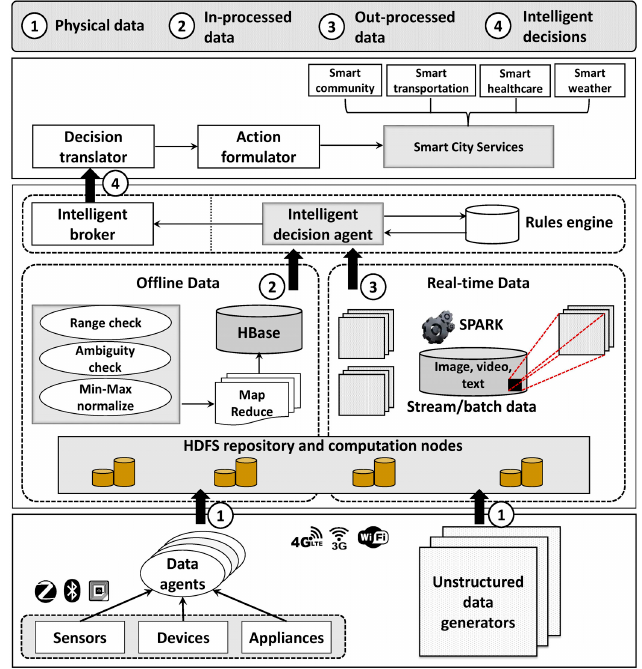
Figure 2. Dataflow and workflow of the proposed architecture.